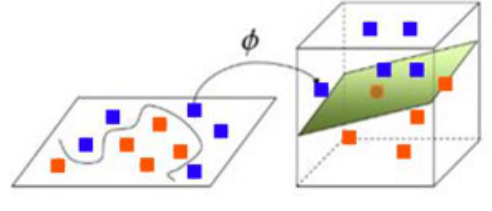
Figure 4. SVM Kernel projection from 2D to 3D